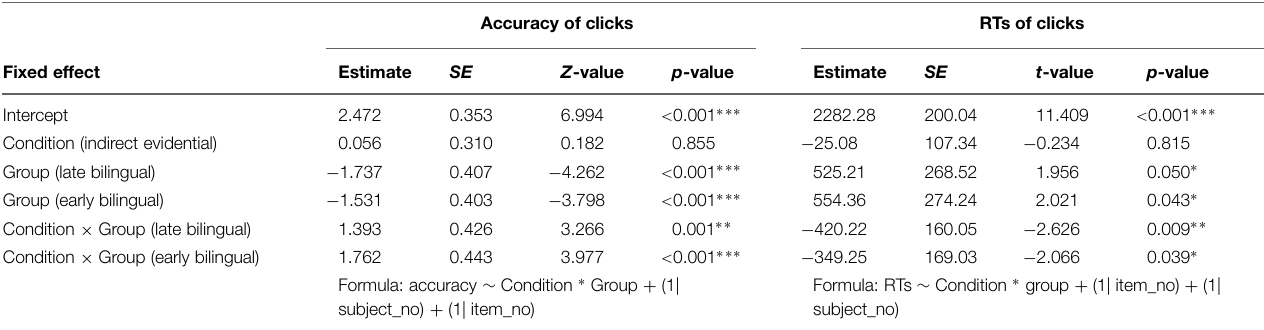
TABLE 3 | Fixed effects from the generalized linear mixed-effects regression models performed on accuracy of clicks and linear mixed-effects regression model performed on RTs. Accuracy of